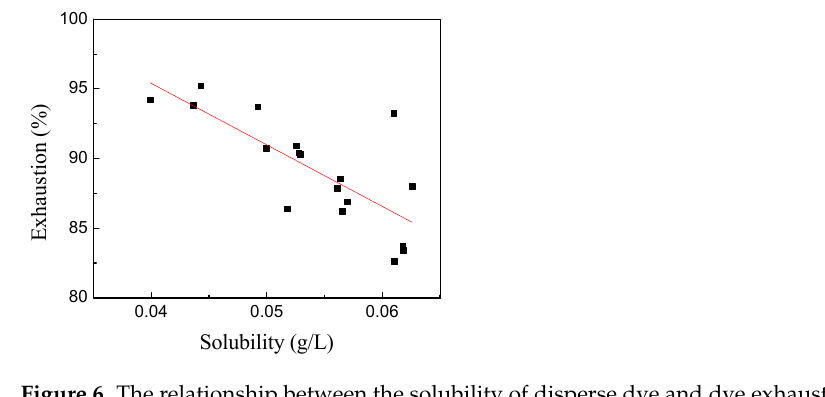
Figure 8. The dispersion mechanism of NNO/MF for disperse dye in silicone solvent dyeing system. 4. Conclusions In conclusion, the final uptake of disperse red 177 was 93.81% and 94.18% in the tra- ditional water-based system and the silicone waterless dyeing system, and the color depth of the dyed fabric was almost the same. The washing and rubbing fastness (wet and dry) of the dyed fabric were found at a level of 4 or 4–5, and the light fastness of the dyed fabric was 3–4. Dispersants NNO and MF, which are homologous dispersants, showed different effects on the polyester fabric dyeing in the silicone waterless dyeing system. Dispersant NNO has a positive effect on dye exhaustion, while dispersant MF can lead to a decrease in dye exhaustion during dyeing. When the amount of dispersant NNO was 1.2%, the dye exhaustion of the dye and the final K/S value of the dyed fabric were improved to 94.18%